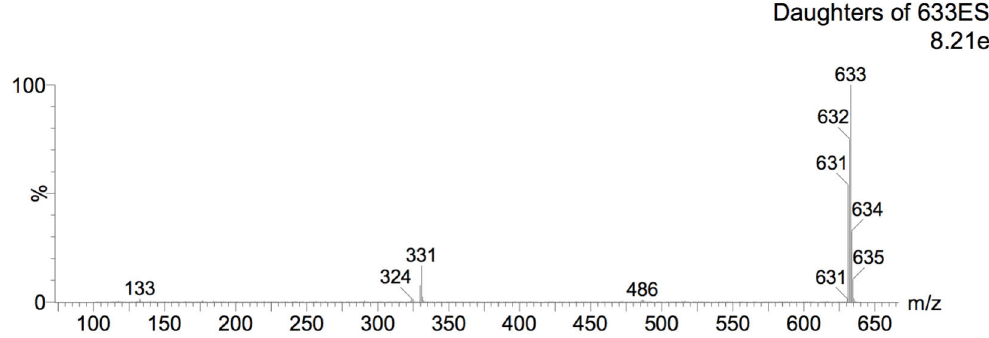
Fig 11. Mass spectrum on ESI positive mode under MRM monitoring for molecular ion m/z 633.